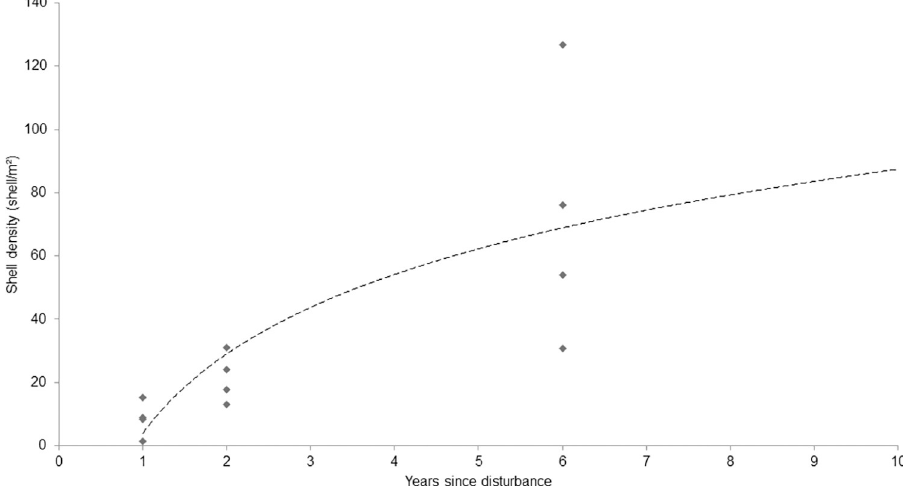
Fig 4. Logarithmic model of shell density by years since disturbance. y = 36.327ln(x) + 3.785 R 2 =